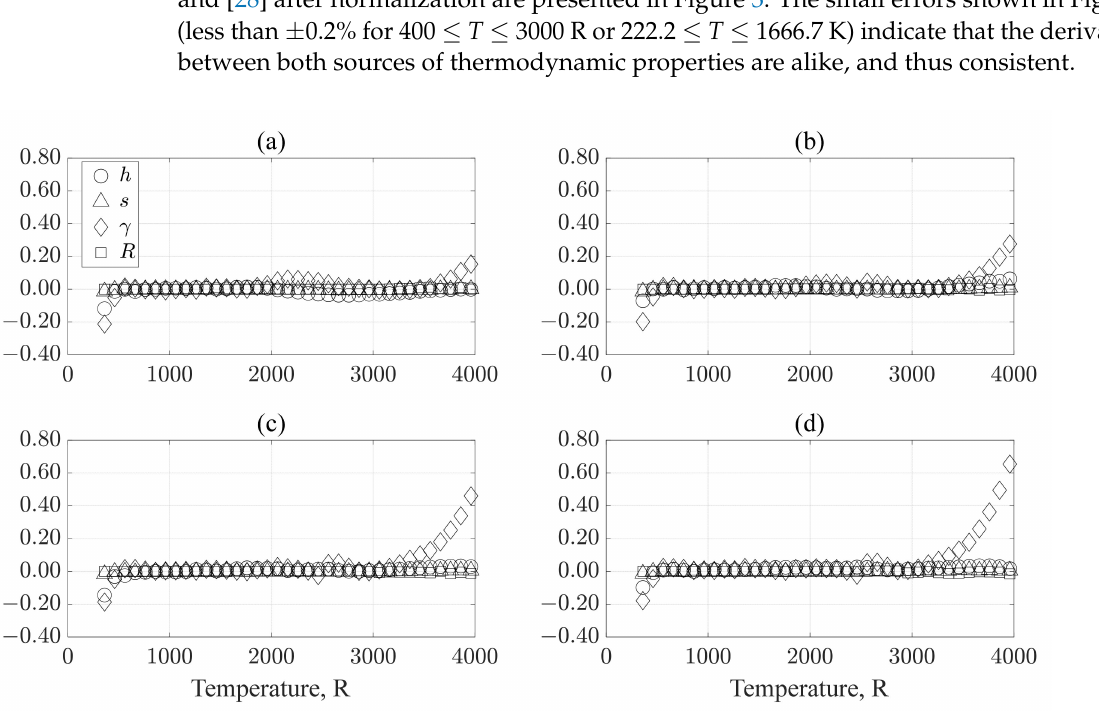
Figure 3. Numerical Propulsion System Simulation (NPSS) ‘allFuel’ thermodynamic package vs. [28] (P = 1.0 atm). ( a ) Φ = 0.0 (upper-left), ( b ) Φ = 0.25 (upper-right), ( c ) Φ = 0.50 (lower-left), ( d ) Φ = 0.75